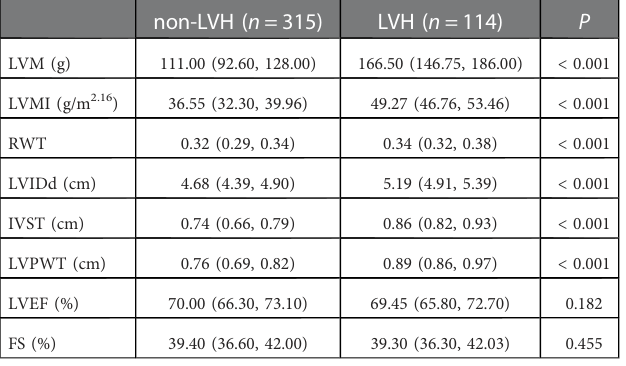
TABLE 2 Echocardiography parameters in LVH and non-LVH group.